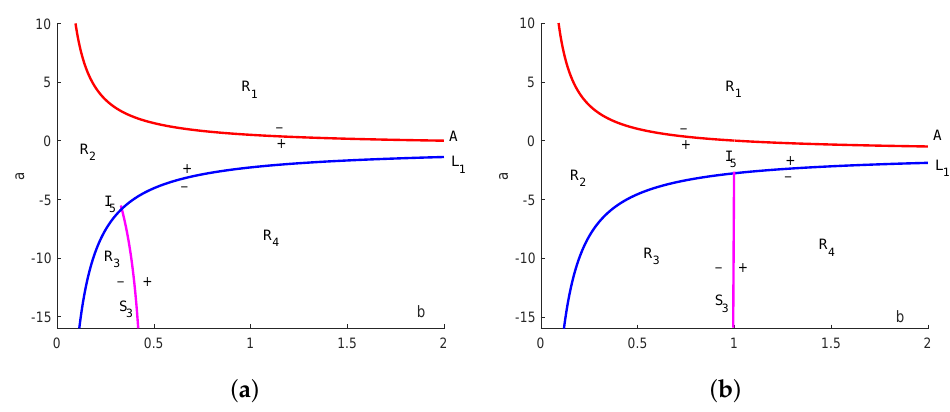
Figure 3. Bifurcation diagrams of the system (3) for m > 0, d > 0 and ( a ) c > 1, respectively, ( b ) c =